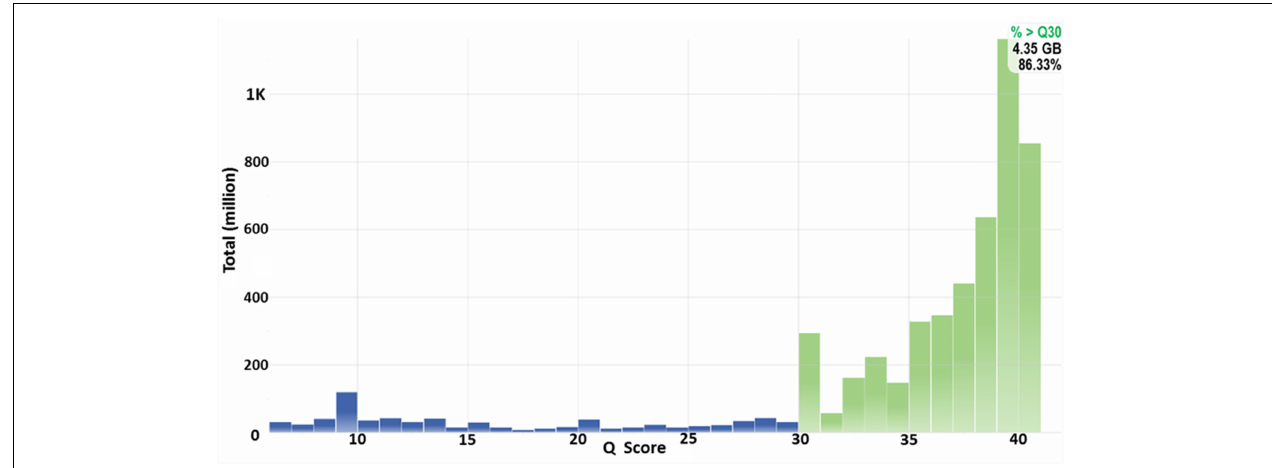
FIGURE 1 | Q 30 graph of Illumina reads. Phred-like quality scores (Q-scores) are used to measure the accuracy of nucleotide identity data from a sequencing run. A higher quality score indicates a lower probability that an individual base is called incorrectly, where Q = − 10 log 10 (e). Q 20 indicates the